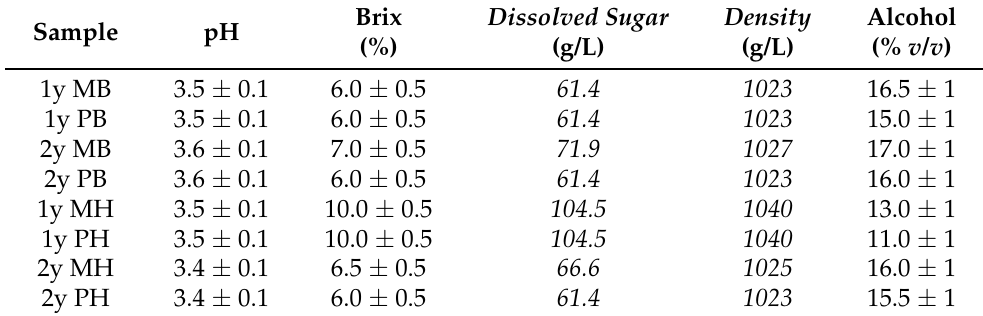
Table 7. Physico-chemical parameters of 1 and 2-year-old wine, control and plasma treated (MB-PB, MH-PH) samples. Measured pH, Brix, the estimated ( italic ) dissolved sugar and density by using VinoCalc [90], and measured alcohol by using vinometer (mean ± standard